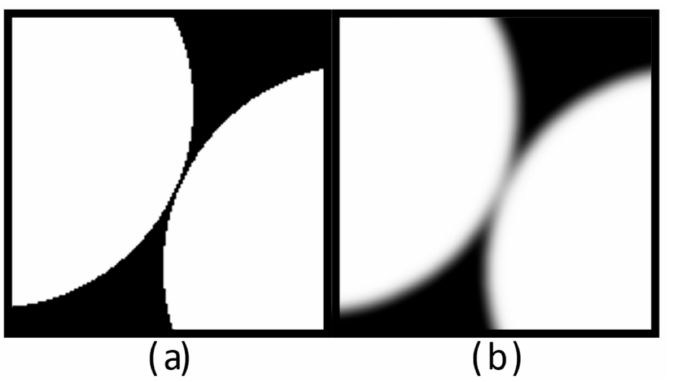
Figure 1. Representation of two non-contacting particles ( a ) and the effect of simulated partial volume blur ( b ), resulting in an increase in greyscale tone of the pixels in the gap between